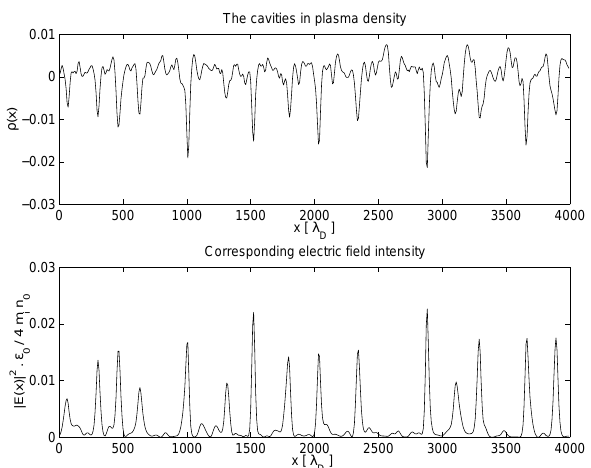
Fig. 1. A time snapshot of the electric field intensity | E(x) | 2 and density fluctuation ρ(x) showing the cavities in the density and cor- responding electric field